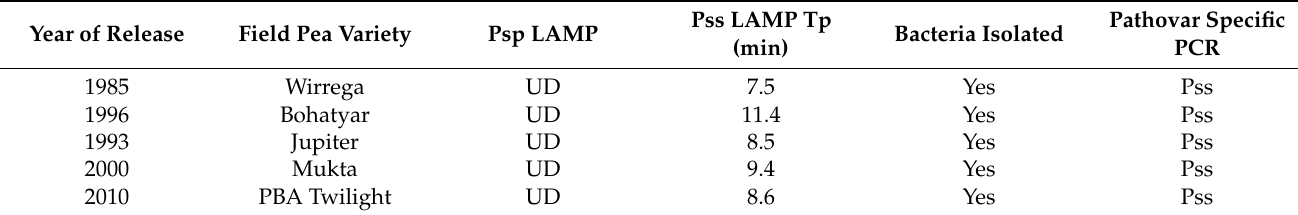
Table 4. Naturally infected bacterial blight samples of field pea collected from PHIST19 variety trial at Horsham for the detection Pseudomonas syringae pathovar pisi (Psp) and Pseudomonas syringae pathovar syringae (Pss) with the LAMP